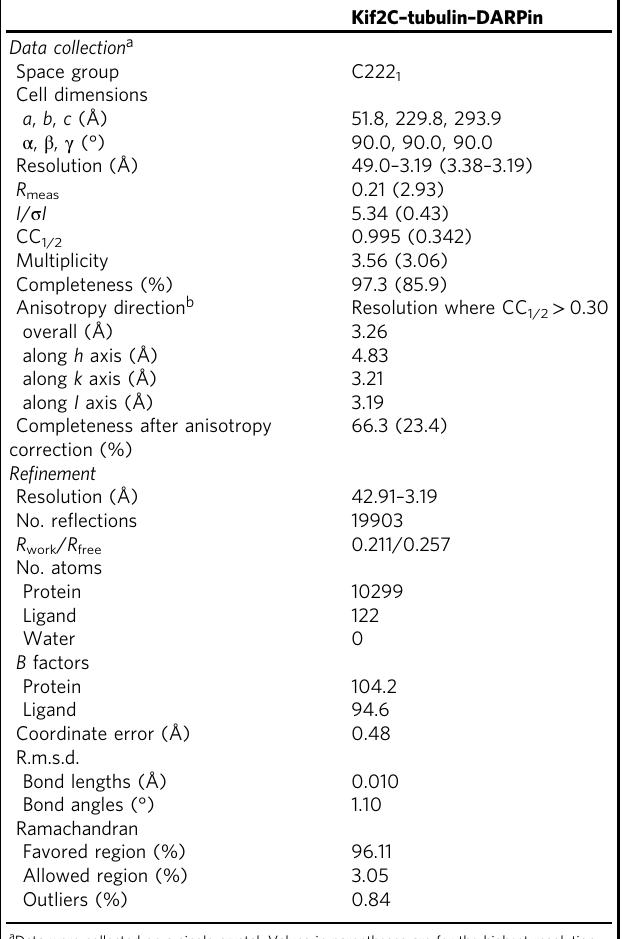
Table 1 Data collection and re fi nement statistics